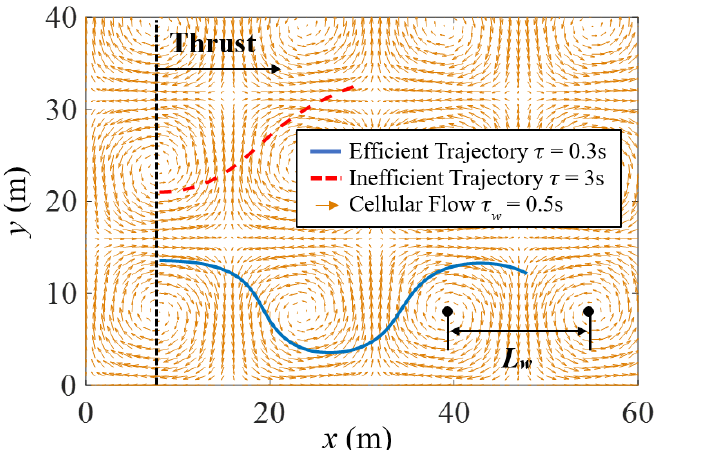
Figure 2. The trajectories of two particles with different inertial response times ( τ ) are compared by allowing them to travel for the same amount of time through a cellular flow field with vortex time scale ( τ w ) after they are both released at the dashed black line (see [70] for